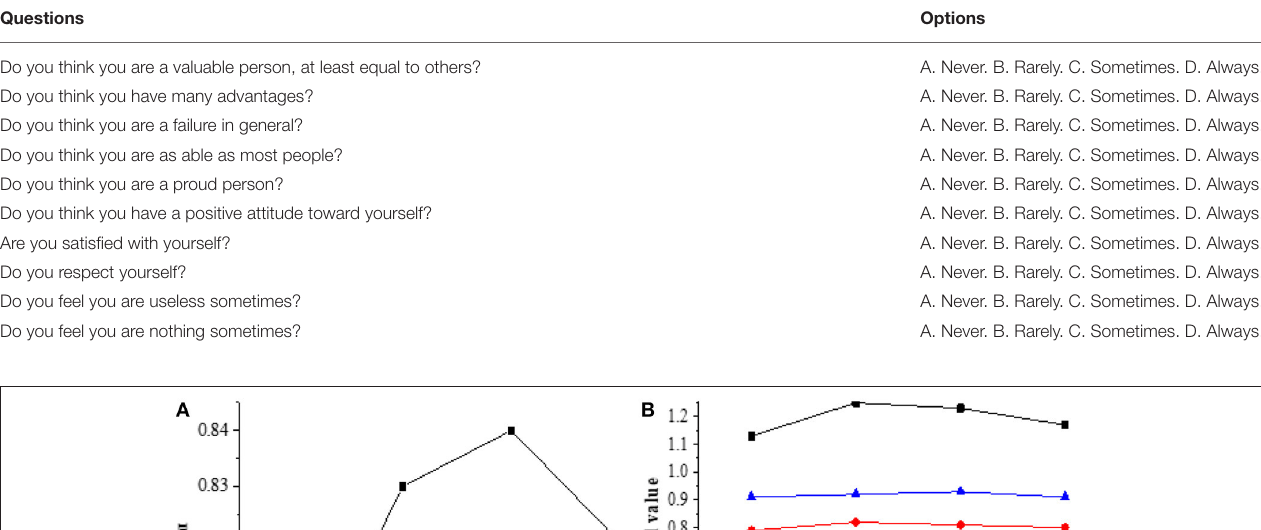
TABLE 6 | Self-confidence scale. Questions Options